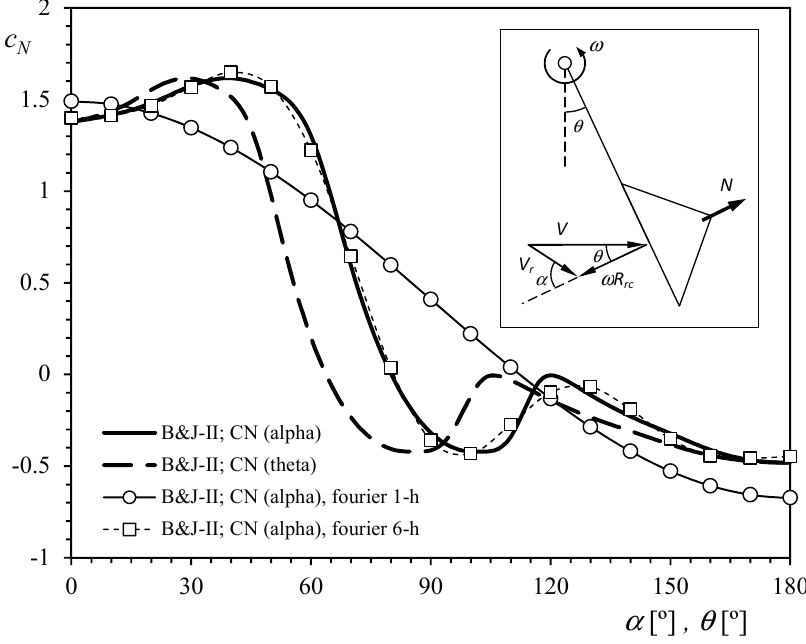
Figure 5. Experimentally measured normal aerodynamic force coefficient, c N , of the Brevoort & Joyner Type II (conical) cups [25], plotted as a function of the wind direction with respect to the cup, α . The coefficient is also plotted as a function of the rotor’s rotation angle, θ (calculated with Equation (22) for an anemometer factor K = 3.5). See in the sketch the variables involved in the rotation of an anemometer’s cup: normal aerodynamic force on the cup, N , wind speed, V , relative wind speed to the cup, V r , rotor’s rotation angle, θ , rotor’s rotational speed, ω , and wind direction with respect to the cup, α . The 1-harmonic term Fourier series approximation (Equation (24)) to the Type II cup has been plotted, together with the 6-harmonic terms Fourier series approximation (Equation